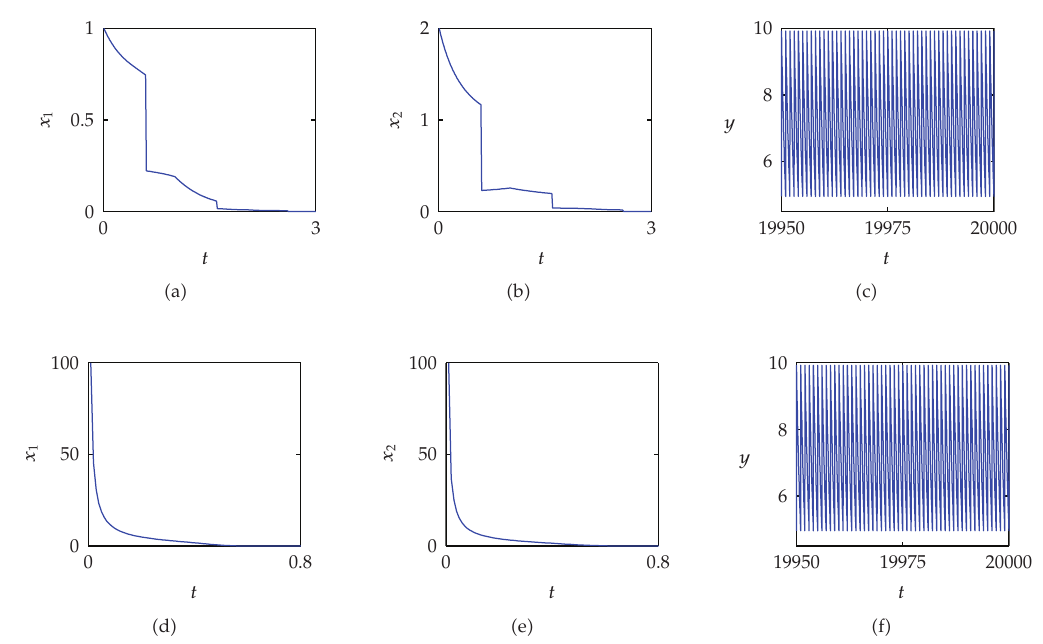
Figure 1: (cid:3) a (cid:4) – (cid:3) c (cid:4) Time series of system (cid:3) 1.2 (cid:4) with an initial value (cid:3) 2 , 3 , 1 (cid:4) , (cid:3) d (cid:4) – (cid:3) f (cid:4) time series of system (cid:3) 1.2 (cid:4) with an initial value (cid:3) 100 , 100 , 100 (cid:4)